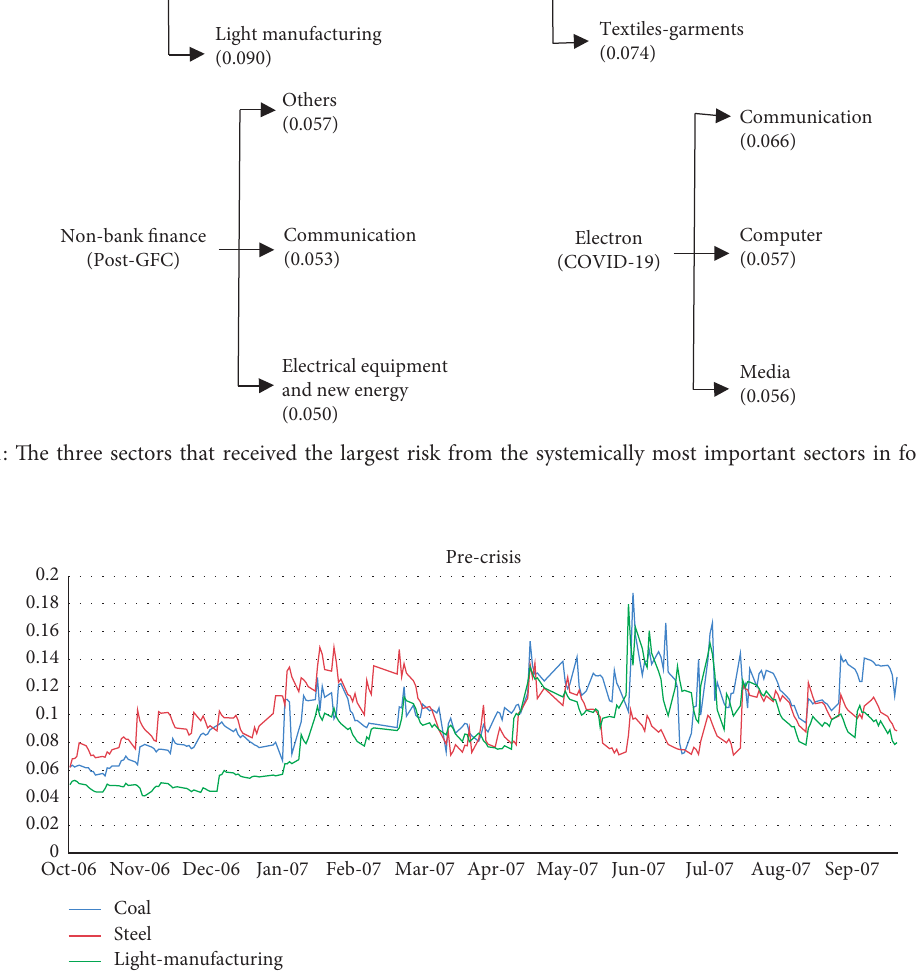
Figure 12: ∆ CoVaR of the coal, steel, and light manufacturing sectors in the pre-GFC